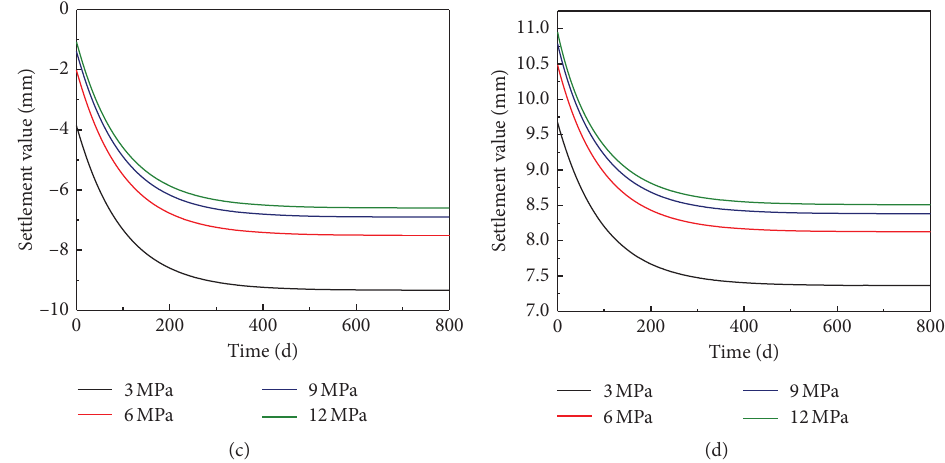
Figure 6: Different shear moduli, G , caused a change in the settlement value at point (–10, 0, 10) with time under the action of the support 1 pressures (a), the shield shell frictions (b), grouting pressures (c), and total displacement over time (d).